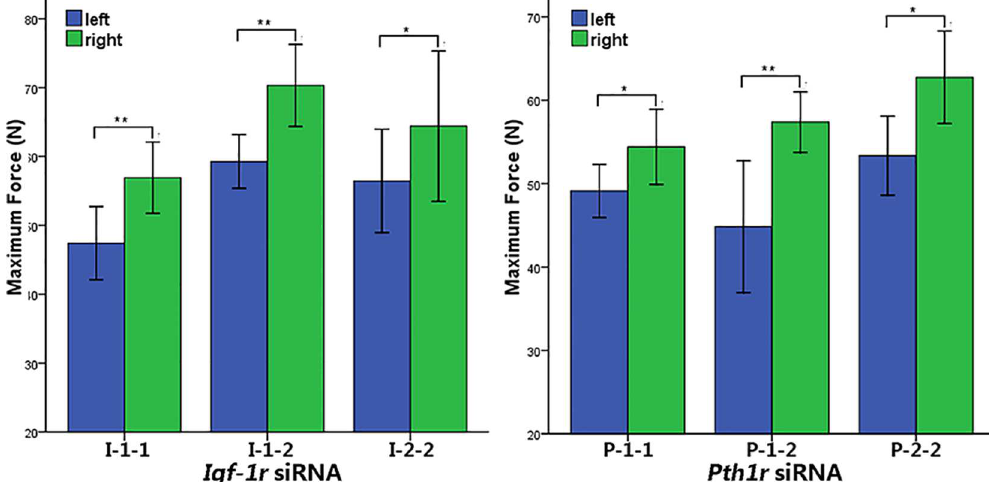
Fig 6. Maximum Force in the Three-point Bending Biomechanical Test. In the Igf-1r and Pth1r siRNA transfectiongroups, the mechanicalpropertiesof the left tibias, which received Igf-1r or Pth1r siRNA injections, were dramatically diminishedcomparedto the right tibias (I-1-1 and P-1-1, one injectionfor one week; I-1-2 and P- 1-2, one injectionfor two weeks; I-2-2 and P-2-2, two injections over two weeks). * p < 0.05and ** p <